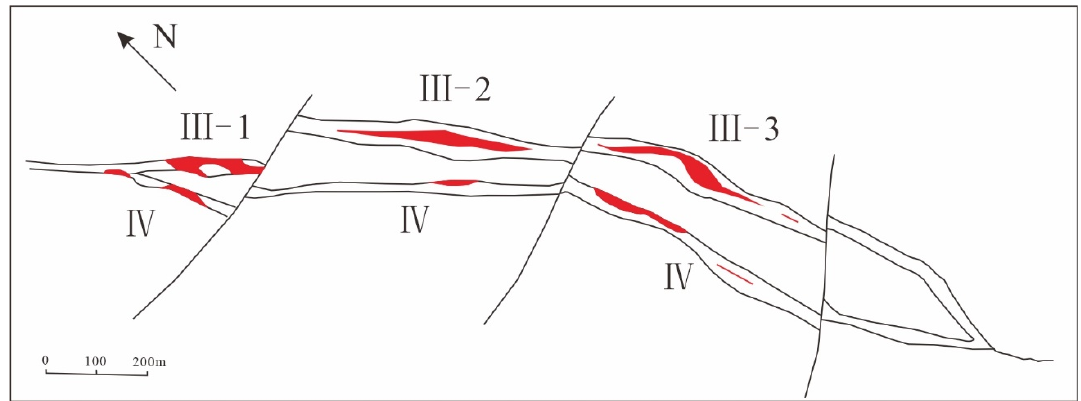
Figure 3. Horizontal projection of the III and IV mineralized belts in the Yanjingou ore body (modified after [10]).